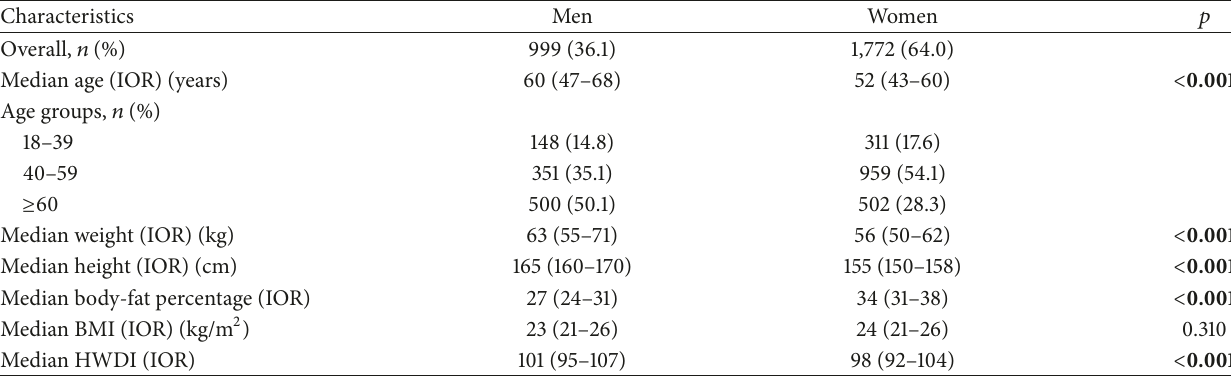
Table 1: Population